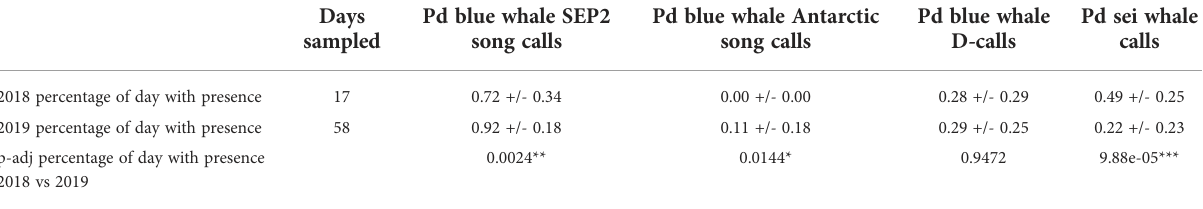
TABLE 2 Summary statistics for percentage of day with presence (Pd) (+/- s.d.) for blue whale song and D-calls, and sei whale calls (downsweeps and upsweeps) per